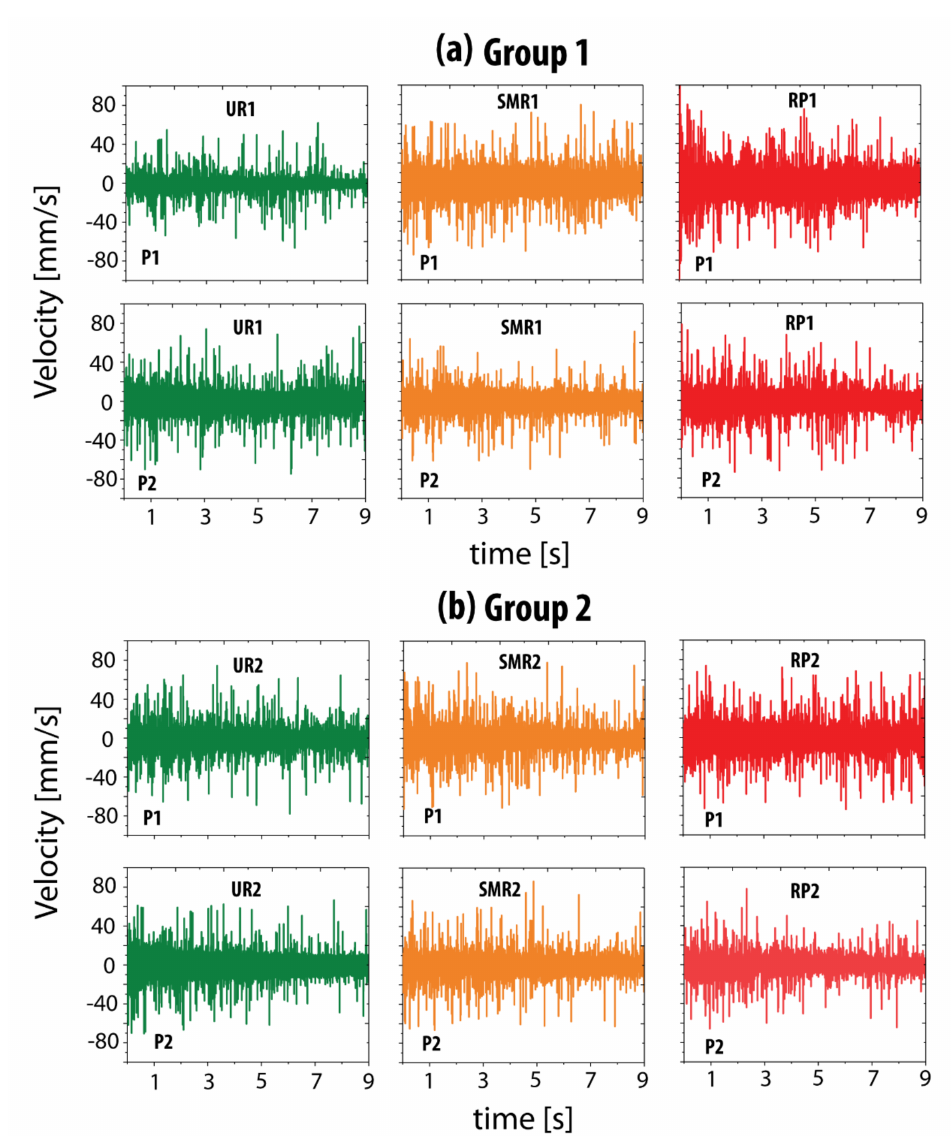
Figure 6. Time-domain results of velocity between 100 and 1000 Hz in e 1 and e 2 . P1 and P2 measure- ments for each sample. ( a ) Group 1 (UR1, SMR1, and RP1). ( b ) Group 2 (UR2, SMR2, and RP2).